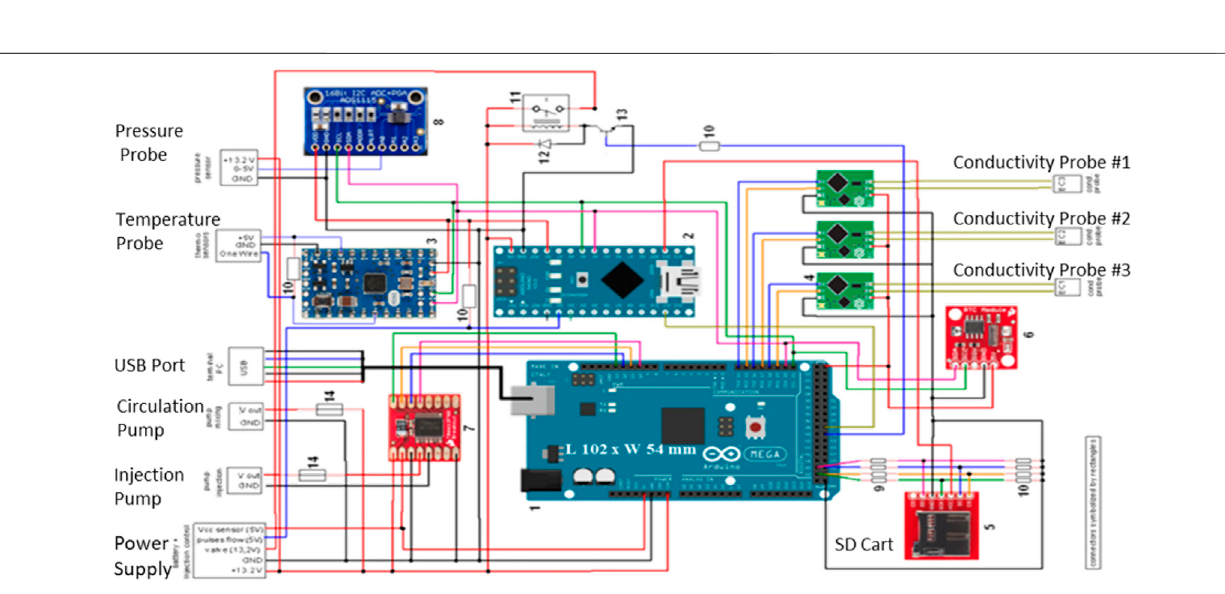
Frontiers in Earth Science |